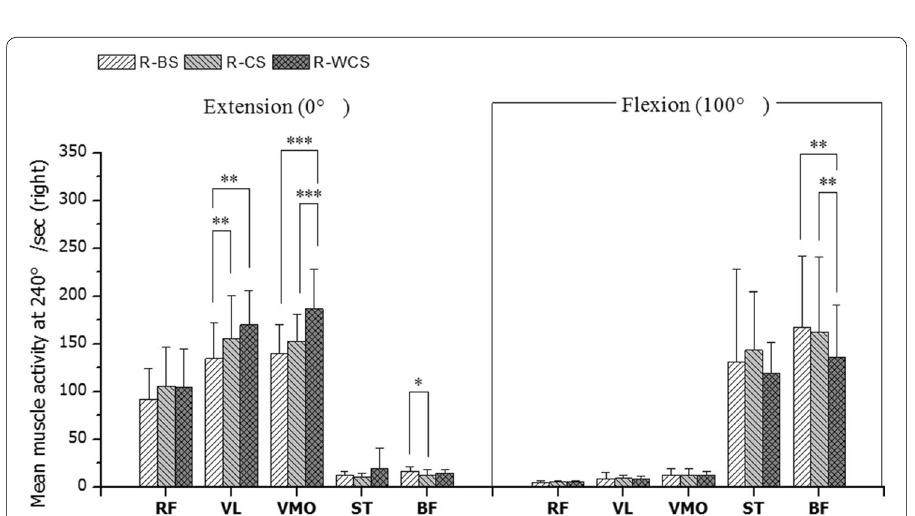
Fig. 8 Mean muscle activities of the right legs at the angular velocity of 240°/s: left (during knee extension); right (during knee